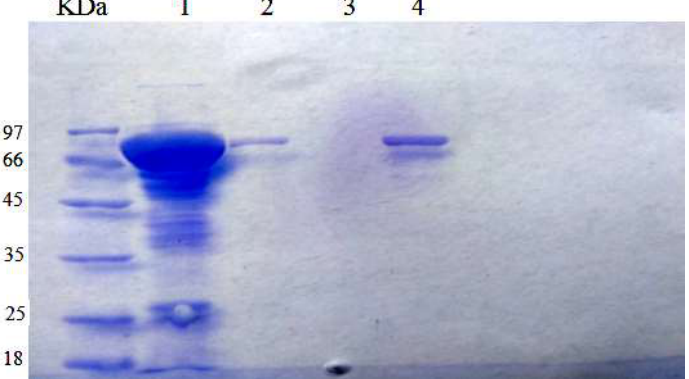
Figure 8. SDS-PAGE gel (M: protein marker, lane 1: free catalase, lane 2: CATZIF-8, lane 3: